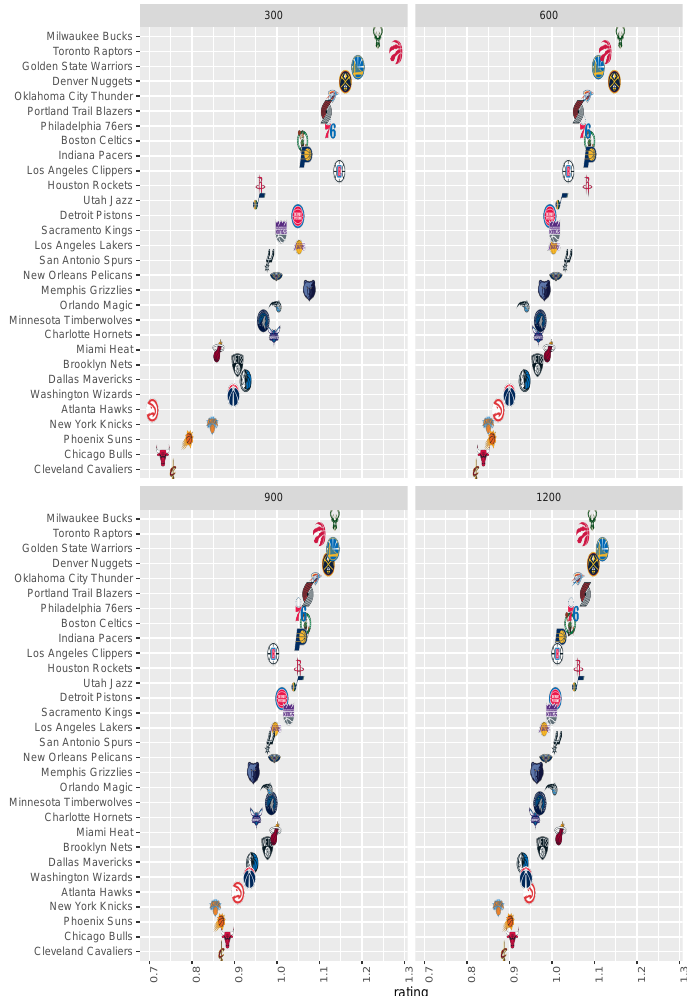
Figure 3. Ranking results for the 2018–2019 season. The four subplots represent the ranking results of 300, 600, 900, and 1200 games,